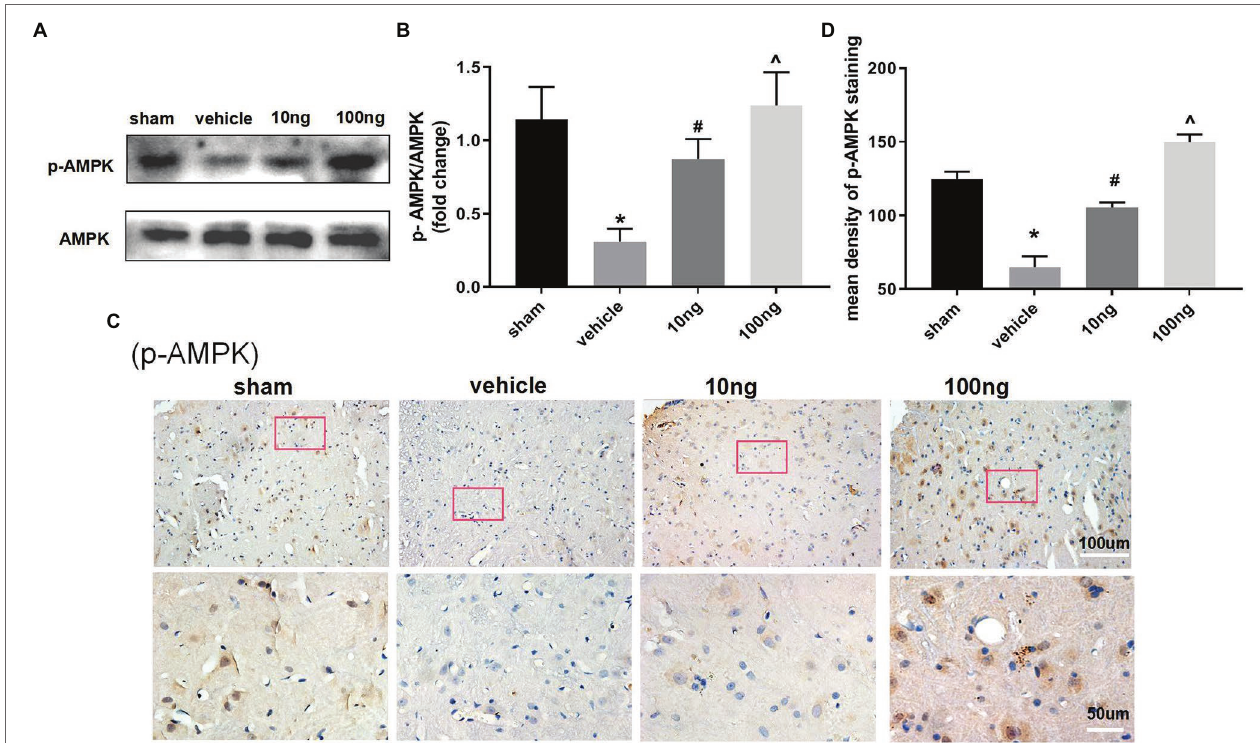
FIGURE 4 | Effect of PDX on adenosine monophosphate-activated protein kinase (AMPK) signal pathway in spinal cord horns ( n = 3/group). Western blot (A) and immunohistochemistry (C) were respectively conducted to evaluate the alterations in the AMPK signaling pathway. Relative to sham group, the protein levels of expression of p-AMPK markedly were suppressed in model rats. Meanwhile, the treatment of PDX could dose-dependently reverse the upper alterations of p-AMPK. Statistical analysis of p-AMPK (B,D) . One-way ANOVA was used for comparisons among groups followed by Turkey’s multiple comparisons test; Values are displayed as mean ± SEM (* p < 0.05 vs. sham group; # p < 0.05 vs. vehicle group; ^ p < 0.05 vs. 10 ng